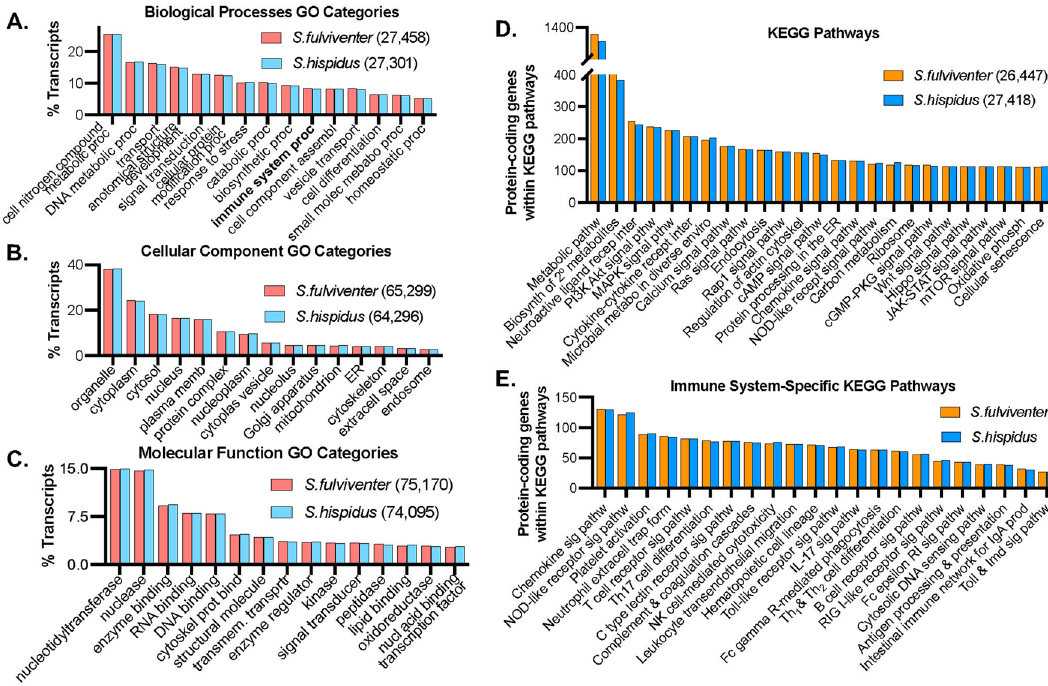
Figure 2. Sigmodon transcriptome annotation. ( A ) Biological processes, ( B ) cellular components, and ( C ) molecular function SwissProt Gene Ontology (GO) terms on the x-axis (total GO’s within respective categories including overlaps represented in figure legends) with number of GO’s (percentage of total ~ 107 k annotated transcripts) on the y-axis; GO’s assigned against TrEMBL/SwissProt database using Trinotate v.3.2.2. ( D ) Top 25 KEGG and ( E ) immune system-specific pathways on the x-axis with total number of protein-coding genes on the y-axis; pathways assigned using TransDecoder-determined CDS followed by GhostKOALA (https:// www. kegg. jp/ ghost